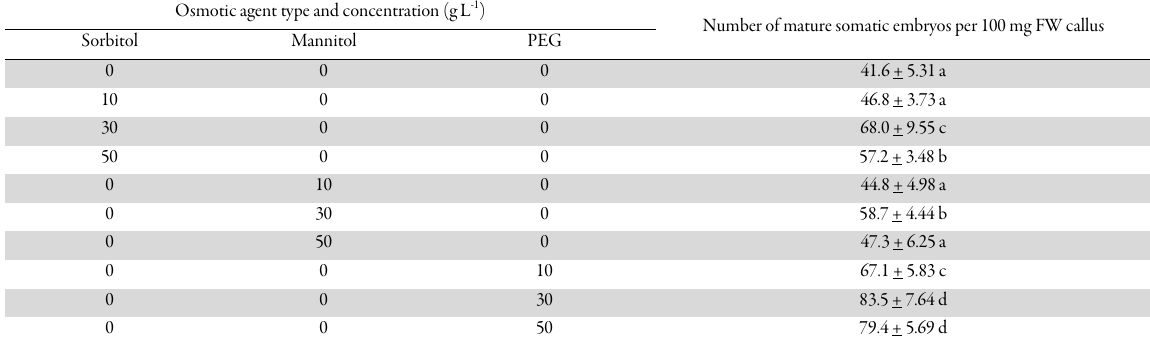
Table 2. Effect of osmotic agents on somatic embryo maturation after 12 weeks of culture Osmotic agent type and concentration (g L -1